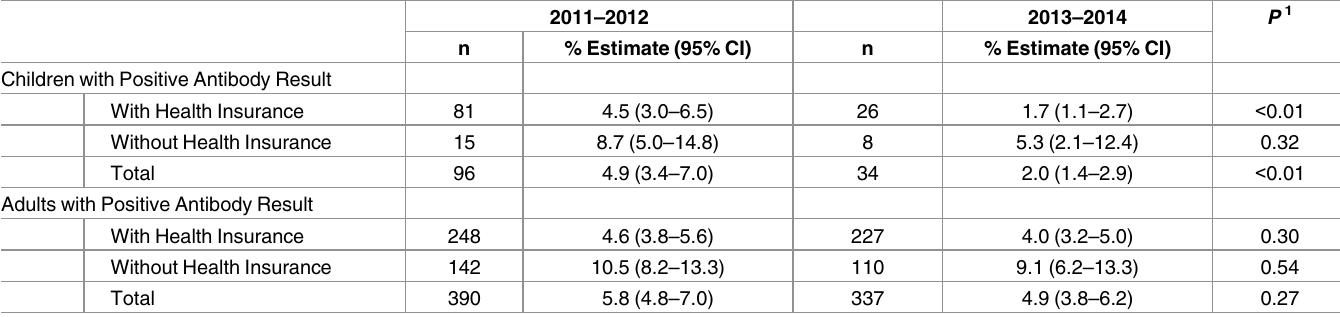
Table 4 shows laboratory results by Toxocara spp. seroprevalence and age category. Sero-